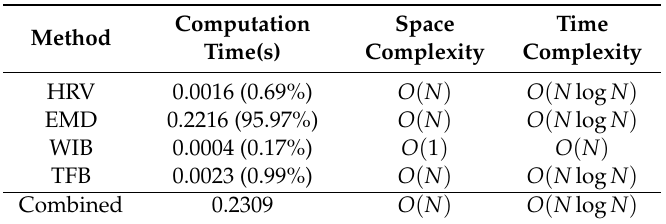
Table 9. Computational